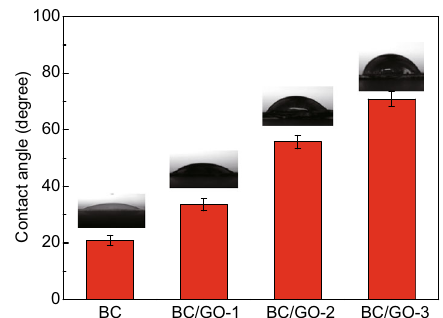
Fig. 5 Water contact angles of BC and BC/GO nanocomposites